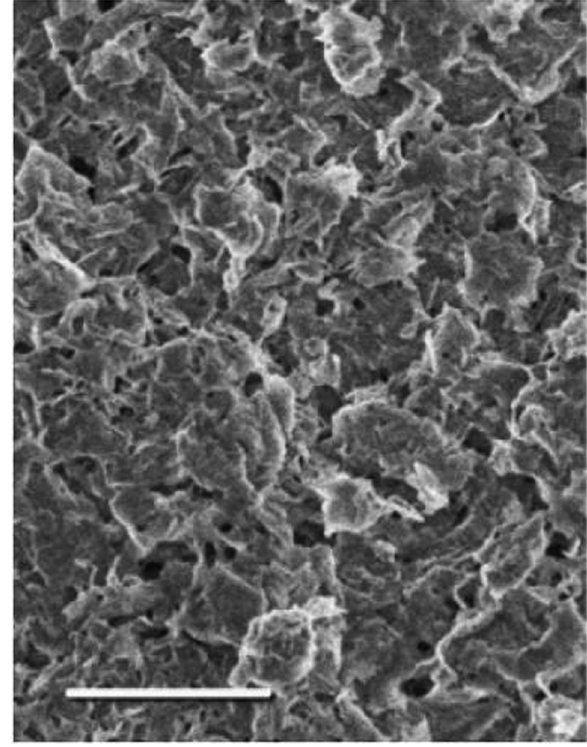
Figure 5: Morphology of the synthetic C - S - H used as a seeding agent during the hydration of C 3 S. The white scale bar indicates 1 mm [ 70 ]